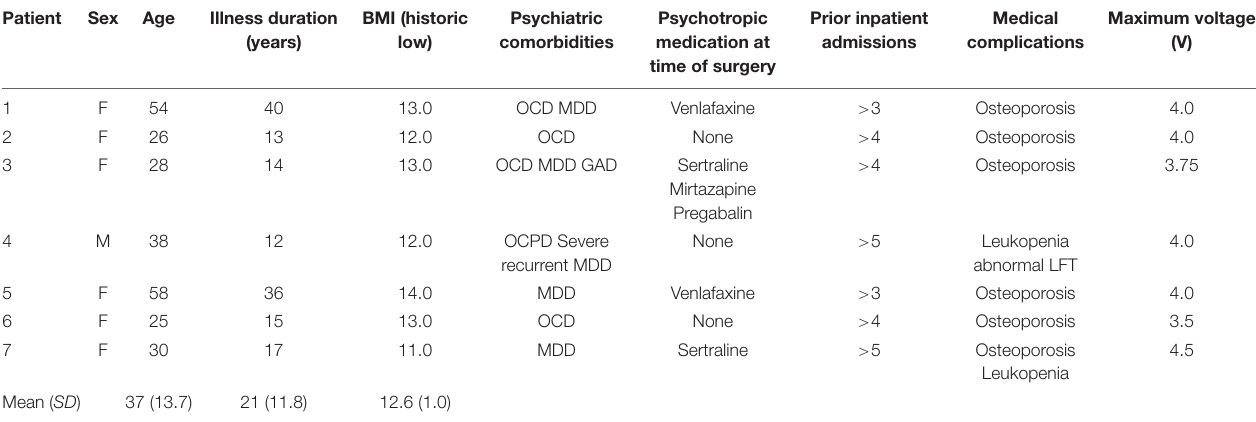
TABLE 1 | Demographic and clinical patient